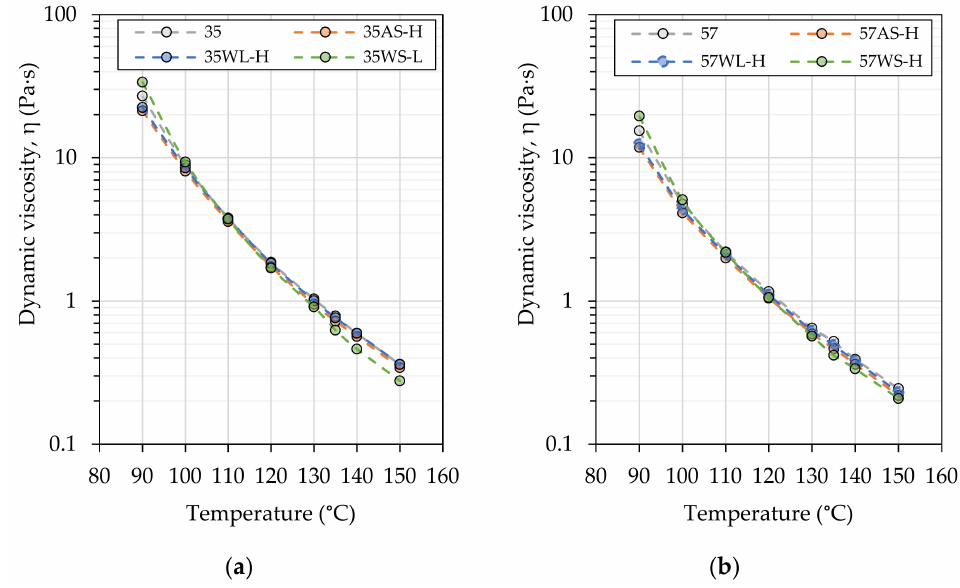
Figure 4. Dynamic viscosity of the investigated asphalt binders based on the ( a ) 35/50- and ( b ) 50/70-penetration